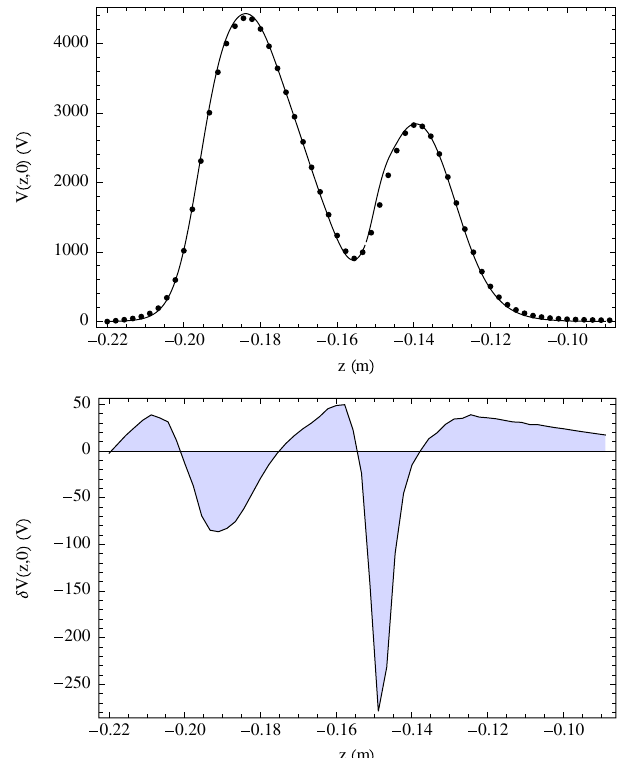
FIG. 2. The line represents the analytical function and the dots are the numerical solution achieved with the finite elements software COMSOL MULTIPHYSICS (cid:2) (top). The difference between the two previous curves is shown in the bottom image. In this case, we applied Bertram’s method replacing R by a function of z . Even though the function is a polynomial going smoothly from R to R , we see that the error is large ( (cid:1) 258 V ) near z ¼ z (cid:1) 0 : 15 m where the transition occurs. Here ( V